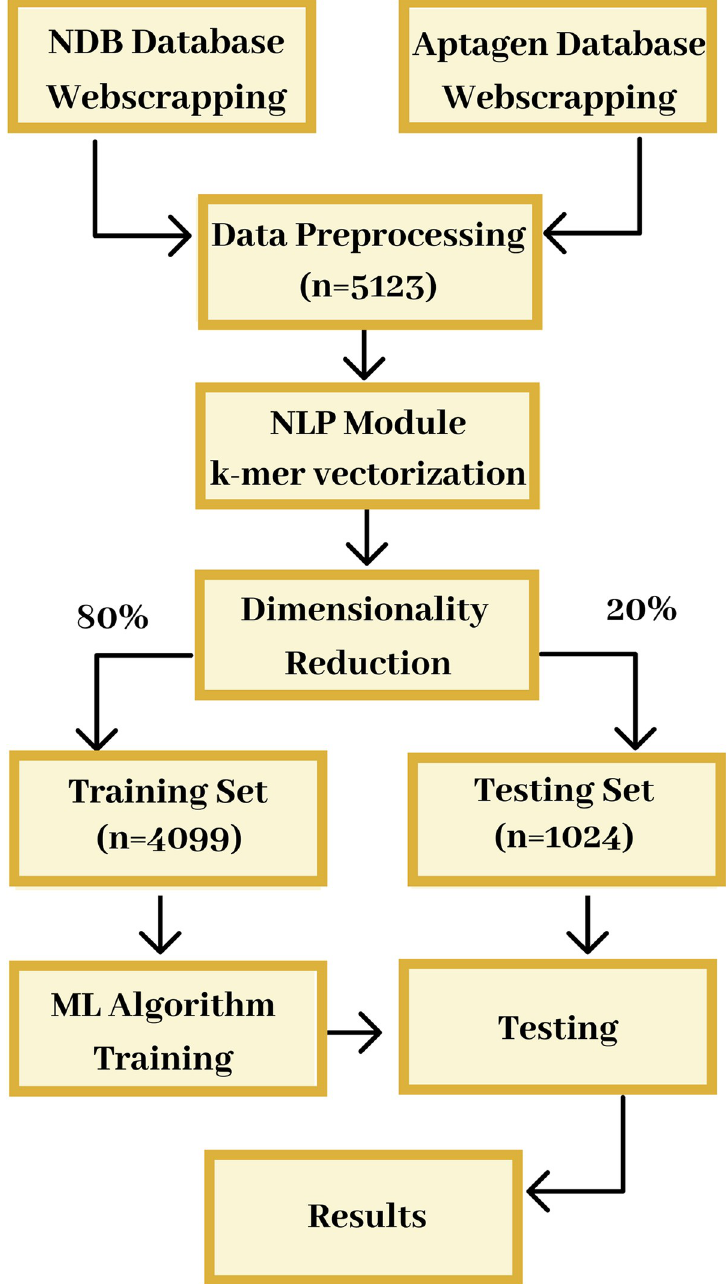
Fig 1. Overview of the AI approach used to obtain a model for the classification of a sequence as an aptamer. It included the extraction of nucleotide sequences from the Nucleic Acid Database (NDB) and Aptagen. The sequences were converted into 6-mer vectors using the NLP modules. Out of the 5,123 vectors created, only the top 2.5% were selected for modeling, in the reduction of dimensionality module. Then the data was split into a training set (80% of the data, n = 4,099) and test set (20% of the data, n = 1,024). Because of data imbalance in the training set, the underrepresented samples were weighted highly. ML algorithms were trained to develop the models using the selected features. The developed models were tested using cross-validation and validated using the test sets. Fig 1 is also the Graphical Abstract.